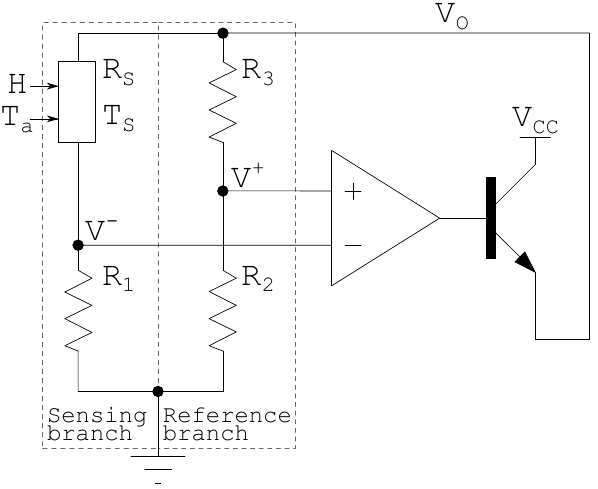
Figure 2. CT Wheatstone bridge schematic using NTC adapted from